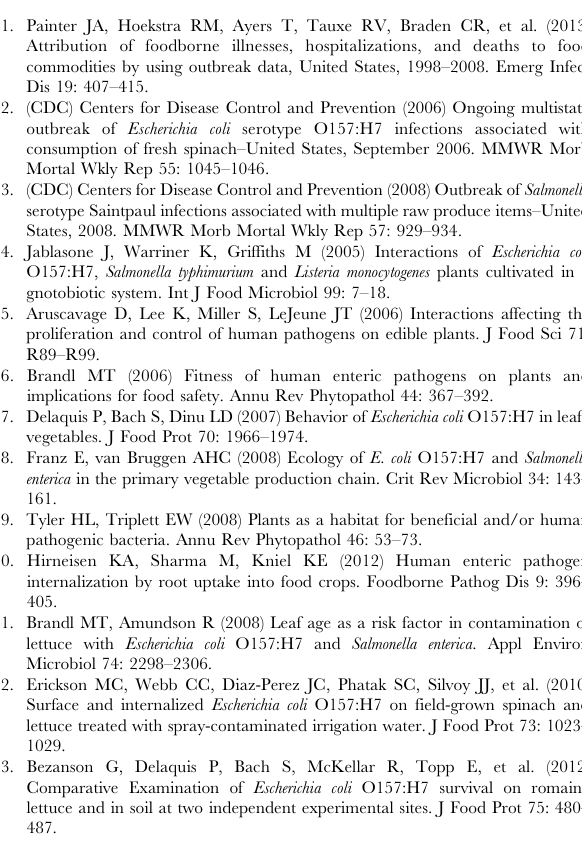
Figure S1 Effect of increasing PMA concentration on detection of live and dead cells by real-time PCR. Live or isopropanol-inactivated dead cells of E. coli O157:H7 ATCC 700728 (5 6 10 6 CFU) were incubated for 30 min in 0, 50, or 100 m M PMA prior to real-time PCR with the lpfA primer set. Each bar represents the mean 6 stdev for three independent replicates. Figure S2 Standard curves for detection of E. coli O157:H7 with hlyA primers (A) and lpfA primers (B) . DNA was extracted by boiling as described in the Materials and Methods from a stationary phase culture of E. coli O157:H7